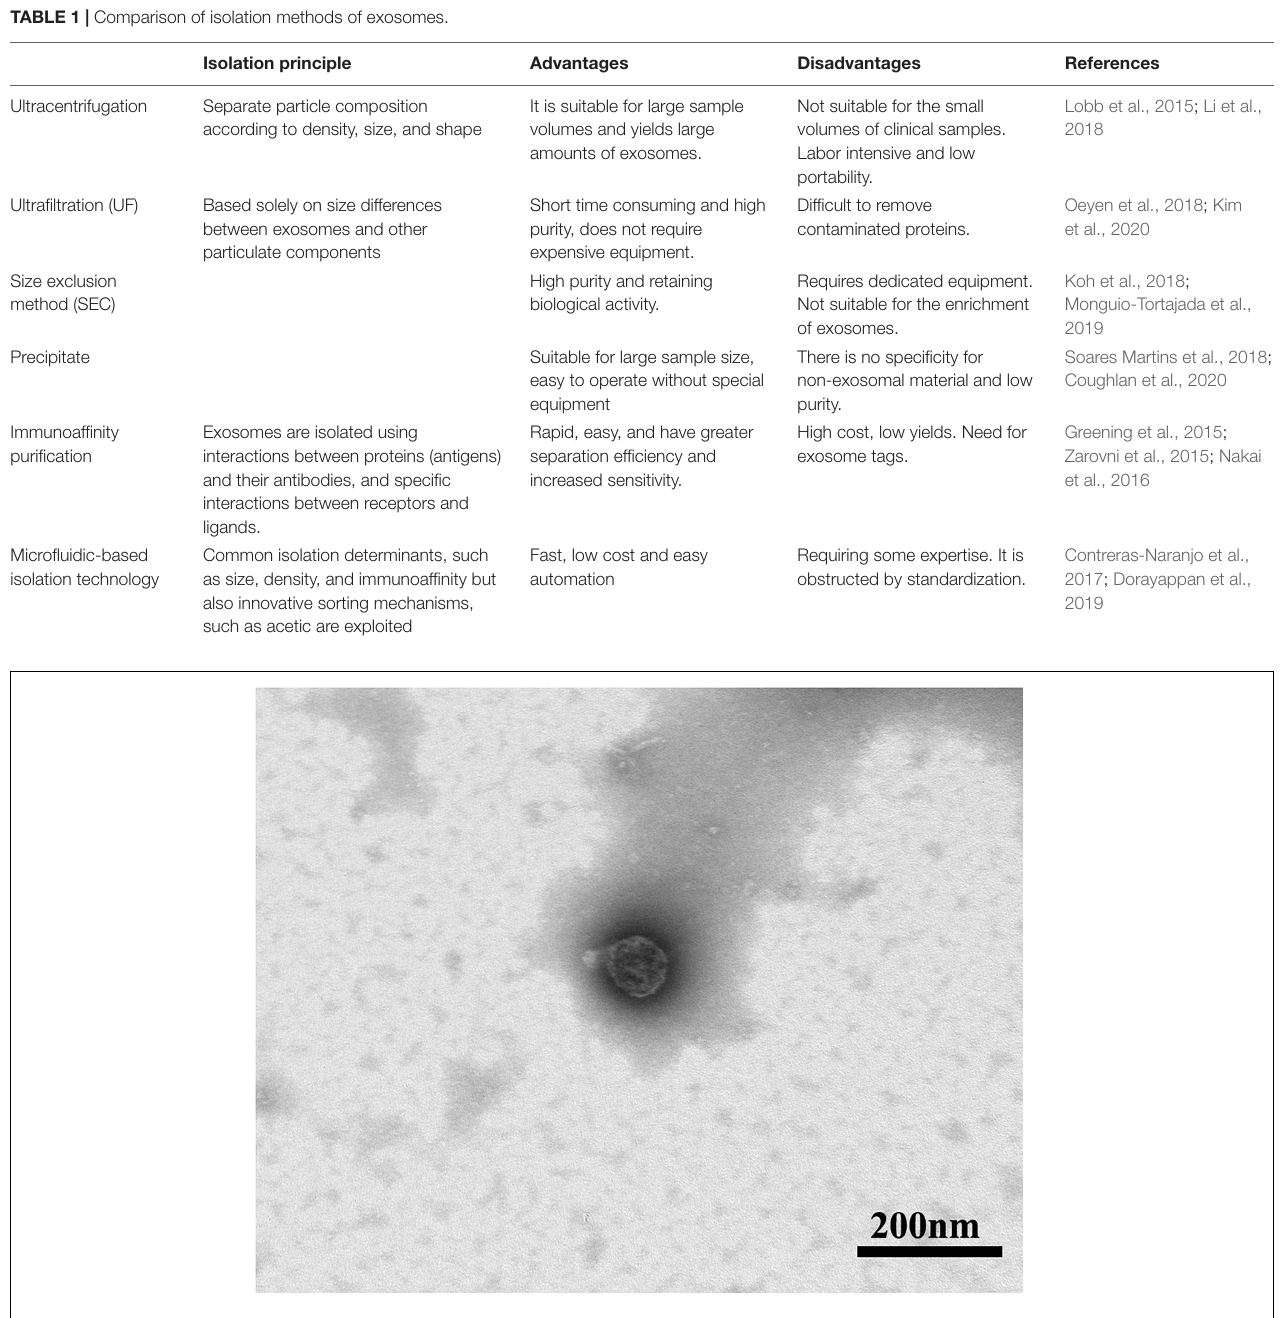
FIGURE 1 | Representative micrographs of transmission electron microscopy obtained from purified rat MSCs-derived exosomes (scale bar: 200 nm).